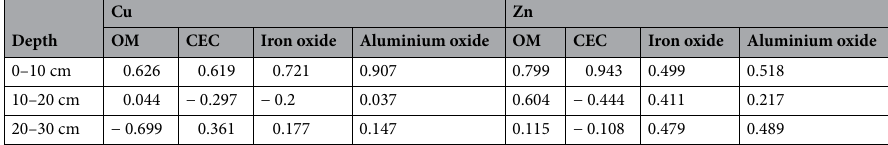
Table 7. Correlation between adsorption capacity and sediment components at three depths along the direction of water flow.